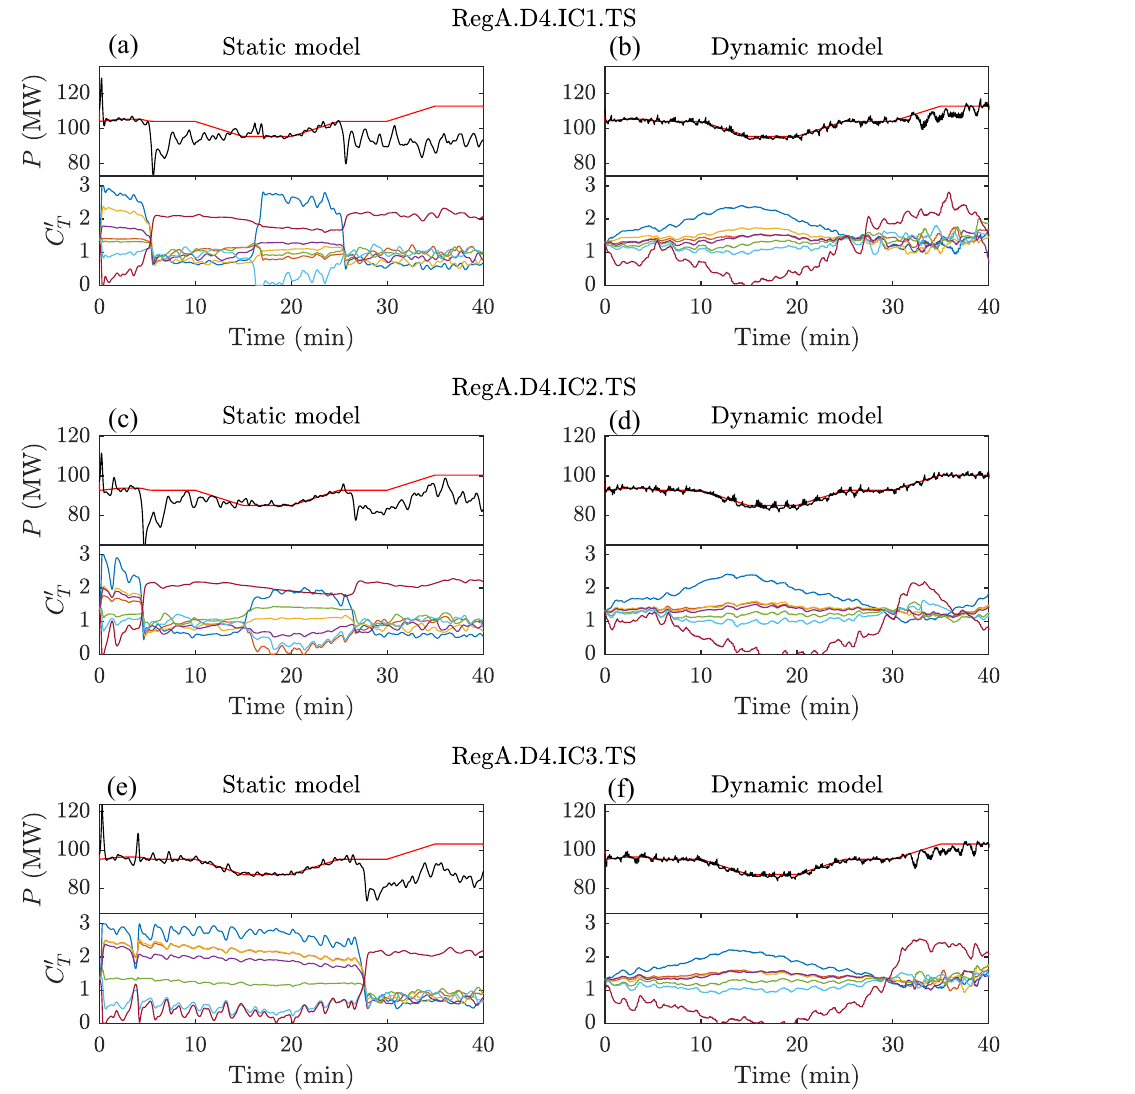
Figure 5. Comparison of static-model (a, c, e) and dynamic-model (b, d, f) control methods for RegA test signals with 4% derates. All three initial conditions are shown from top to bottom. The top plot in each panel shows the controlled LES wind farm model power production (black) compared to the reference signal (red). The bottom plot in each panel shows the local thrust coefficients calculated with control methods by row: row 1 (dark blue), row 2 (orange), row 3 (yellow), row 4 (purple), row 5 (green), row 6 (light blue), and row 7